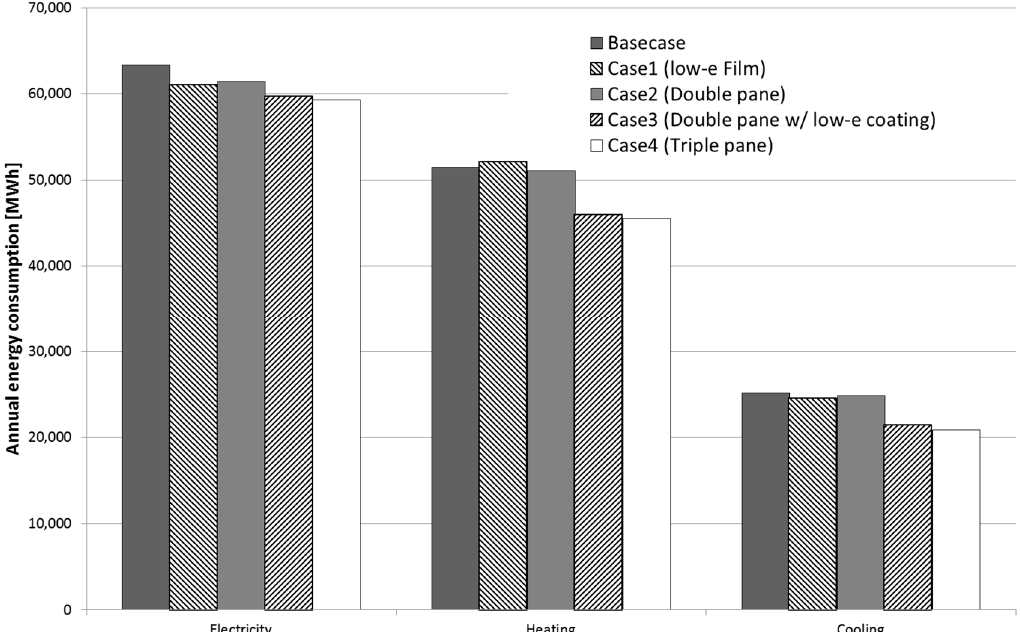
Figure 7. Annual energy saving potentials by fenestration retrofitting.